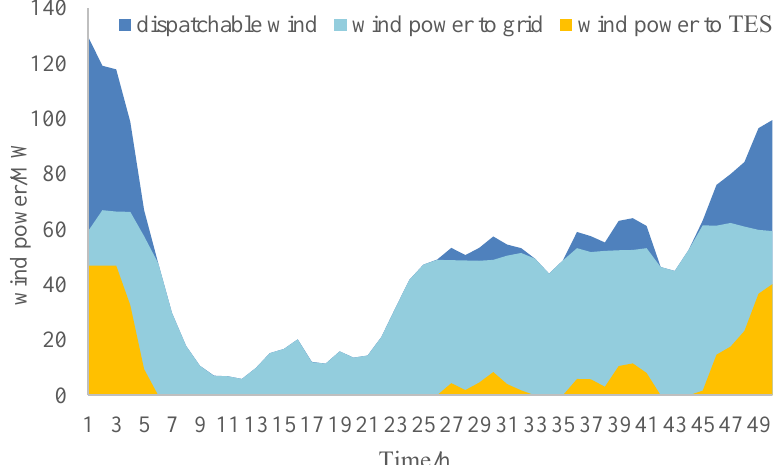
Figure 7. Wind generation with the installation of EB.